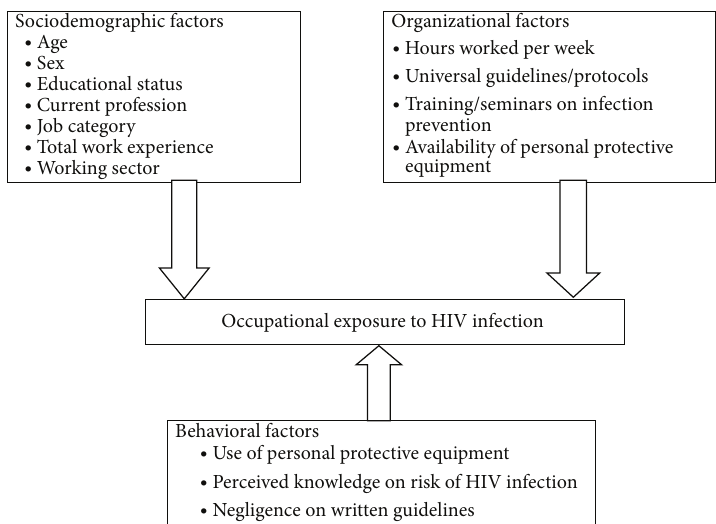
Figure 1: Conceptual framework and variable specification for the study in Debre Berhan town, Ethiopia,